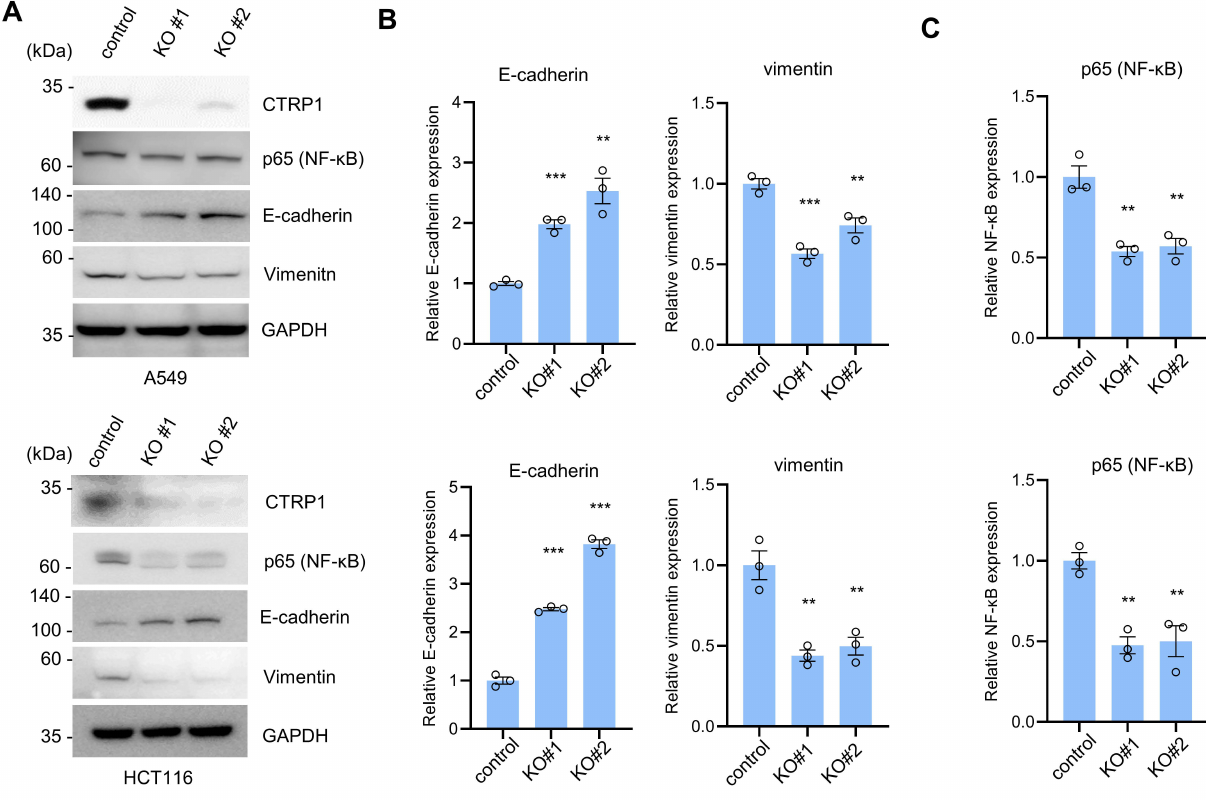
Figure 1. C1q and TNF-related 1 (C1QTNF1/CTRP1) knockout deregulates metastasis marker